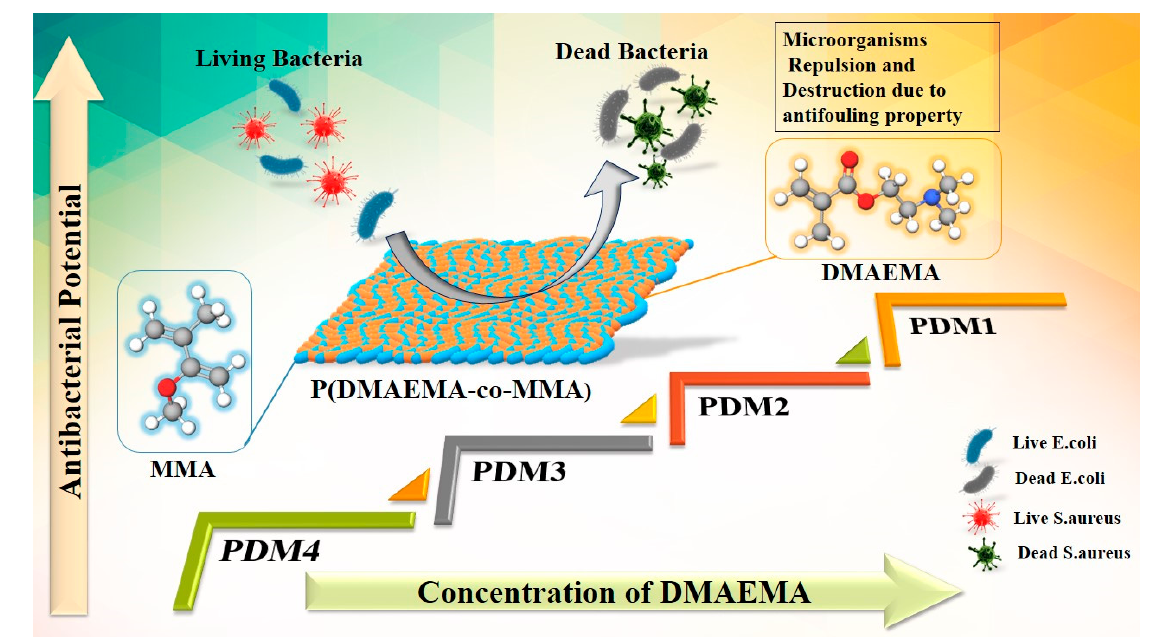
Figure 1. Schematic illustration of copolymers P(DMAEMA and MMA),PDM1, PDM2, PDM3 and PDM4 with varying concentration of DMAEMA that control bacterial adhesion.